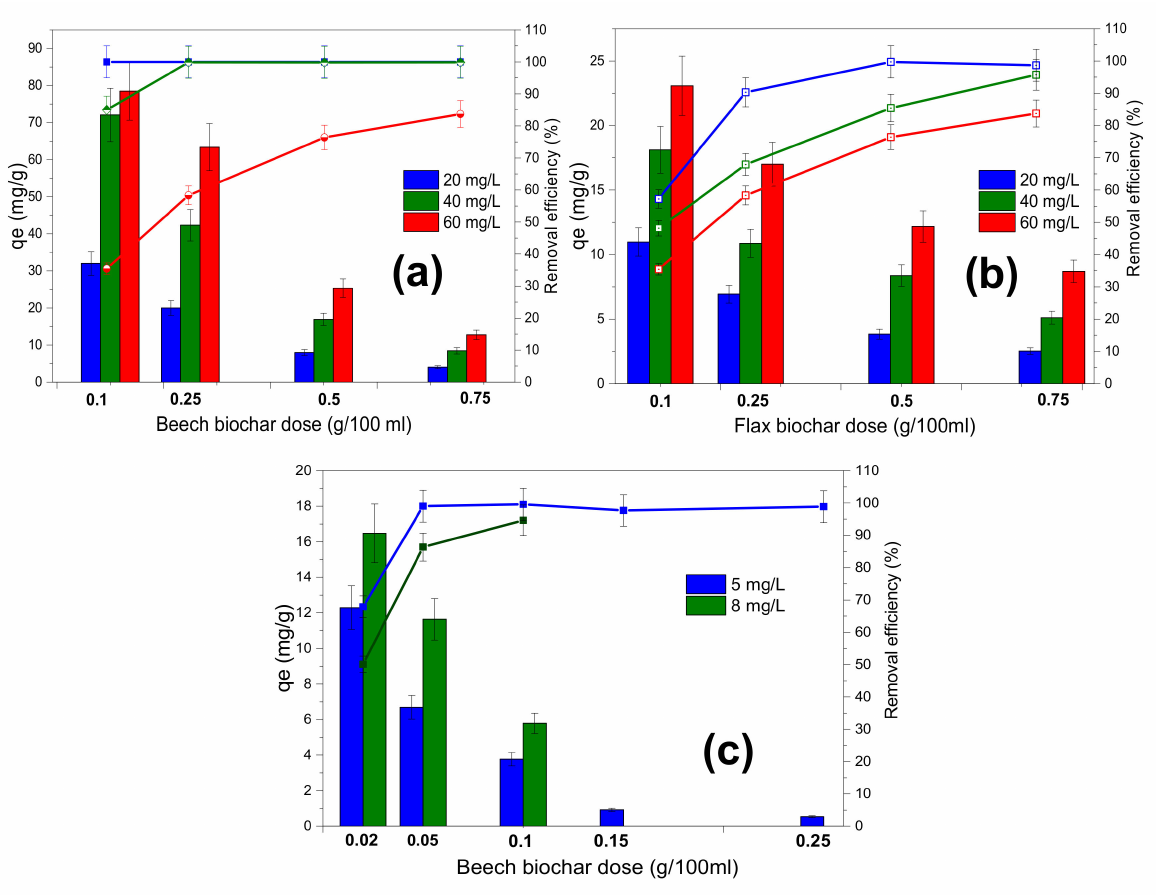
Figure 10. Effect of natural biochar dose on the adsorption capacity (column) and the removal efficiency (line) for: ( a ) beech biochar on MB adsorption, ( b ) flax biochar on MB adsorption, and ( c ) beech biochar on CMZ